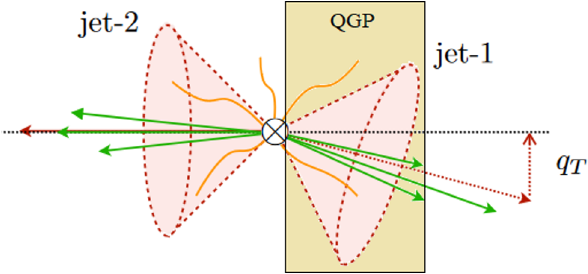
Figure 1. Dijet event in Heavy Ion collision at the periphery of the QGP